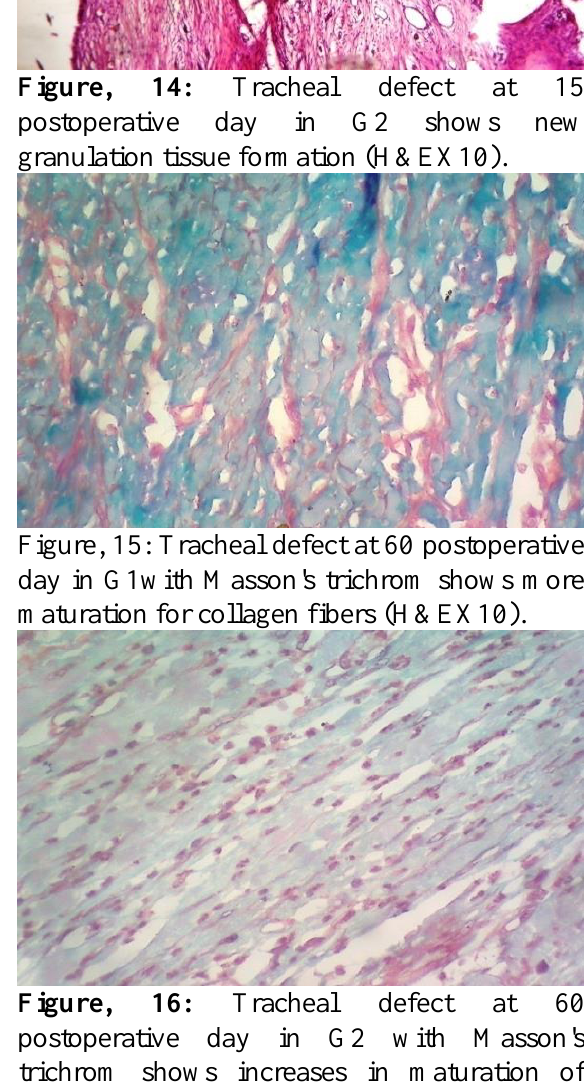
Figure, 14: Tracheal defect at 15 postoperative day in G2 shows new granulation tissue formation (H&EX10).